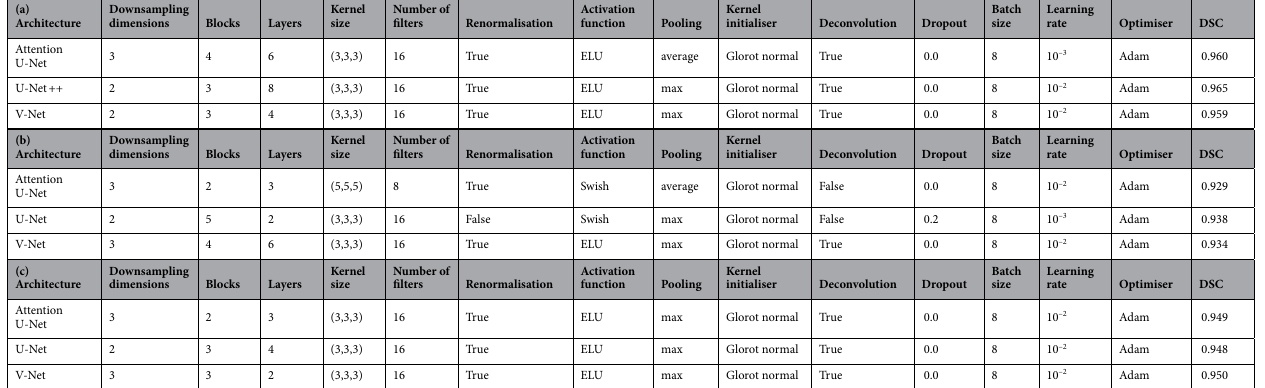
Table 3. Final Models for Diastole Phase Model for: ( a ) diastole phase model for 2MSA, ( b ) systole phase model for 2MSA, ( c ) 1MSA.